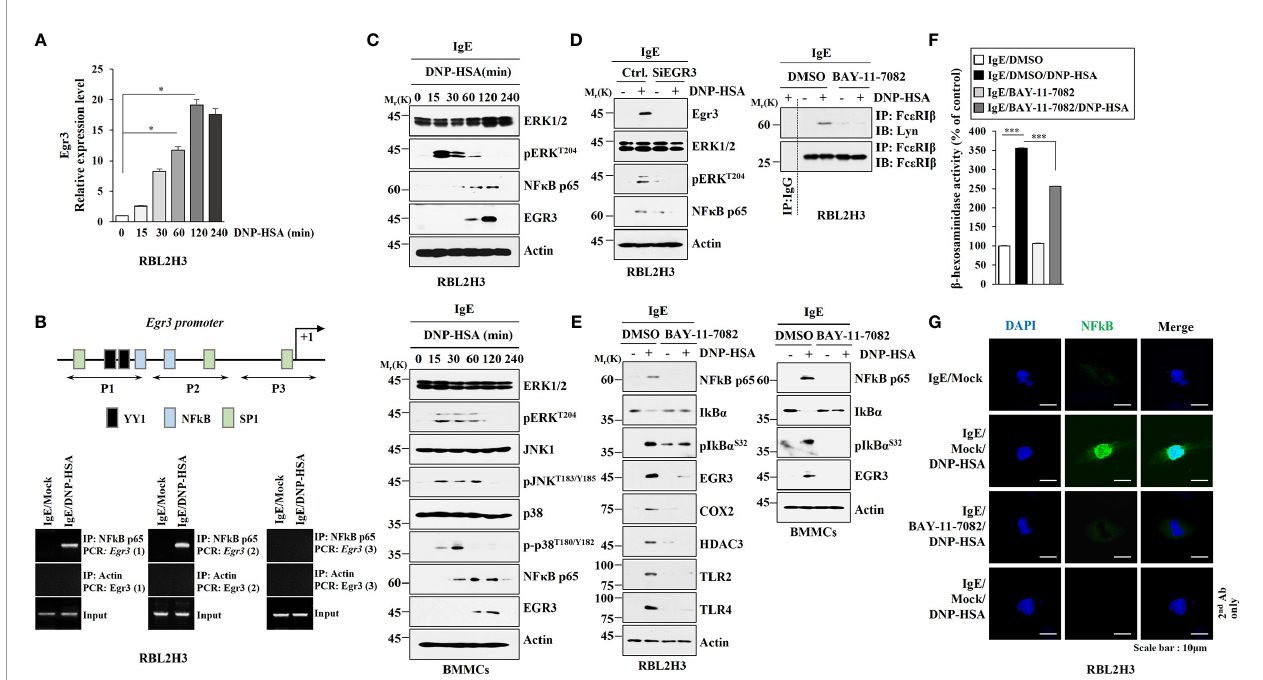
FIGURE 2 | NF- k B directly regulates EGR3 expression and mediates allergic in fl ammation in vitro . (A) Cell lysates prepared at each time point were subjected to qRT-PCR. * p <0.05. Average values of three independent experiments are shown. (B) Shows promoter sequences of Egr3 with potential binding sites for the indicated transcriptional factors. ChIP assays were then performed in RBL2H3 cells treated without or with DNP-HSA for 1h. P1, P2, and P3 denote primer-binding sites. Anti-actin antibody served as a control antibody. (C) The IgE-sensitized RBL2H3 cells (upper) or BMMCs (lower) were treated with DNP-HSA for various time intervals. Representative blots of three independent experiments are shown. (D) RBL2H3 cells were transfected with the indicated siRNA (each at 10 nM). The next day, cells were then sensitized with IgE for 24 h, and then stimulated by DNP-HSA for 1 h. Representative blots of three independent experiments are